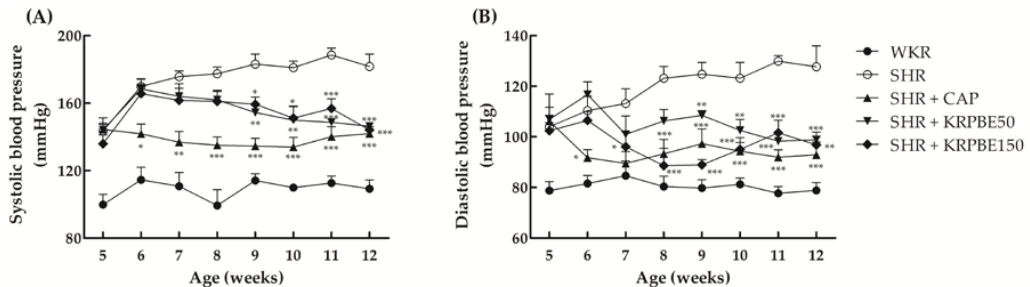
Figure 1. Systolic blood pressure (SBP) ( A ) and diastolic blood pressure (DBP) ( B ) of Wistar-Kyoto rats (WKRs) and spontaneously hypertensive rats (SHRs) during seven weeks of oral administration. WKR group (tap water), SHR group (tap water), SHR + captopril (CAP) group (15 mg/kg body weight/day of CAP), SHR + Korean red pine bark extract (KRPBE)50 group (50 mg/kg body weight/day of KRPBE), and SHR + KRPBE150 group (150 mg/kg body weight/day of KRPBE) were orally administrated for seven weeks. Each group consists of six rats. Tukey–Kramer honestly significant difference test: * p < 0.05, ** p < 0.01, *** p < 0.001 vs. SHR.